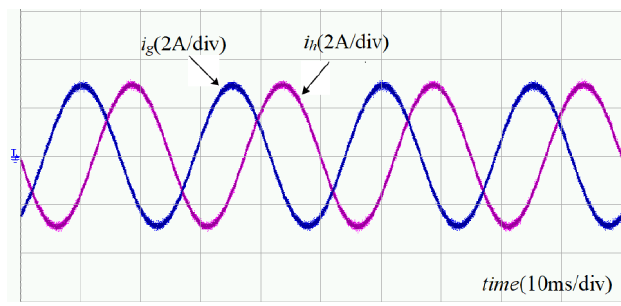
Figure 16. g -axis and h -axis currents of the motor.